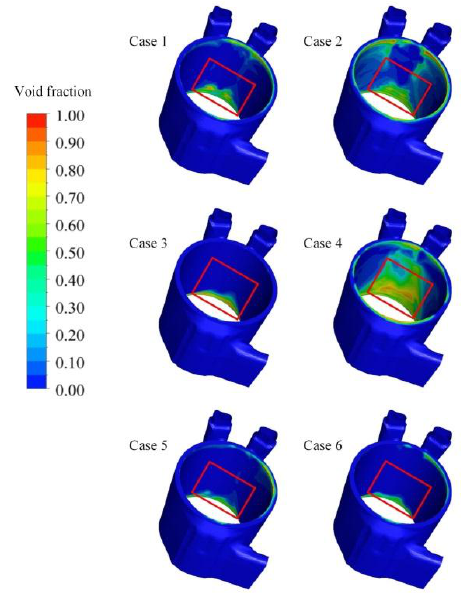
Figure 11. Gas phase distribution of 360° CA.